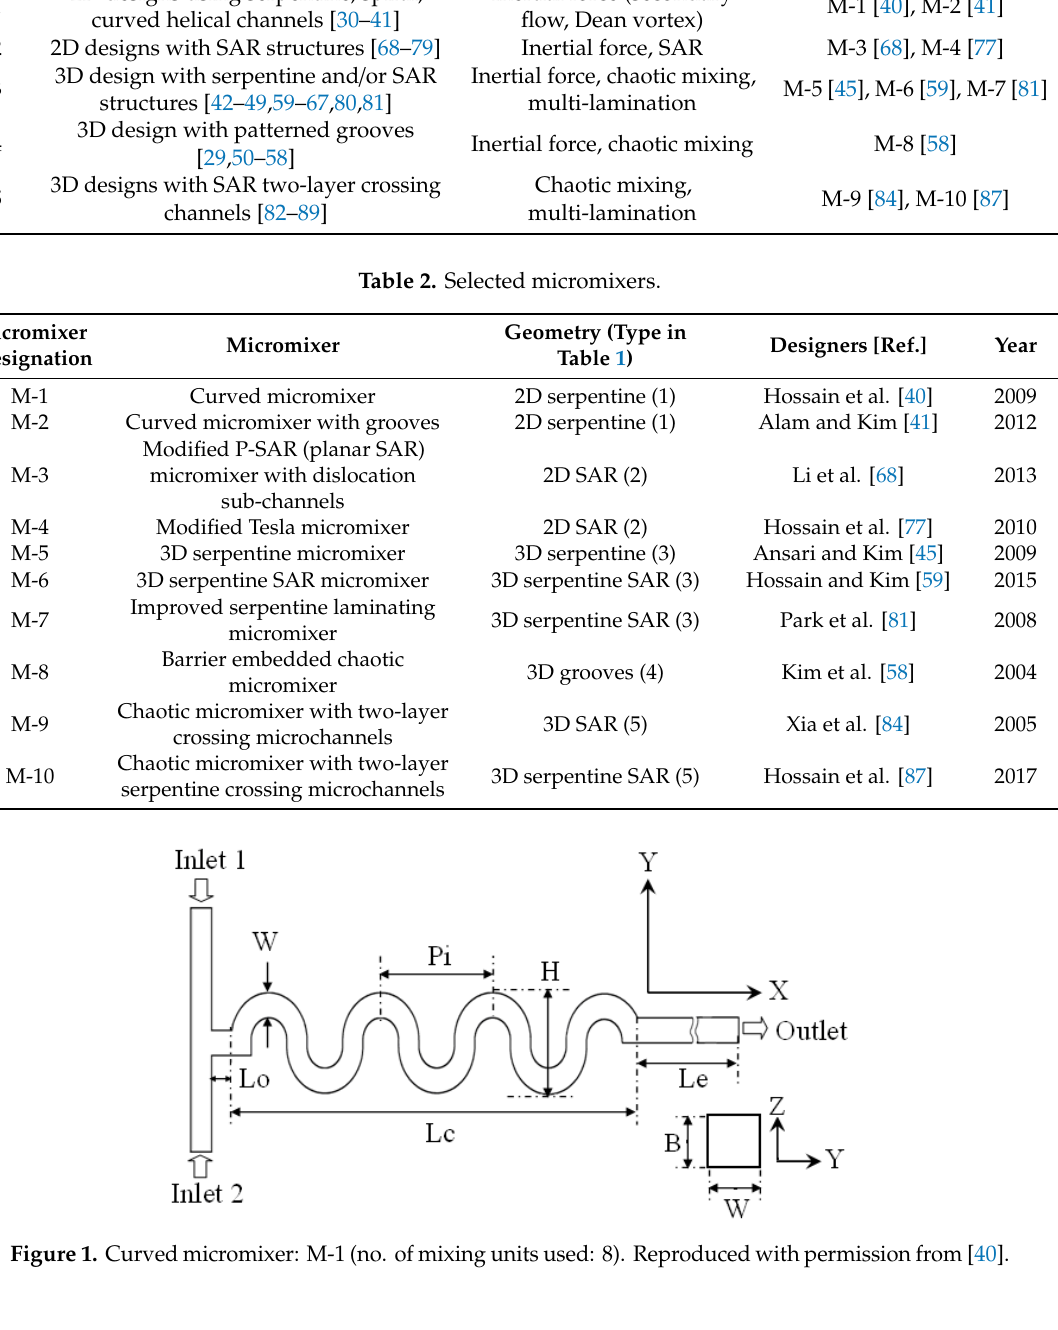
Figure 2. Curved micromixer with rectangular grooves: M ‐ 2 (no. of mixing units used: 8). Reproduced with permission from [41].